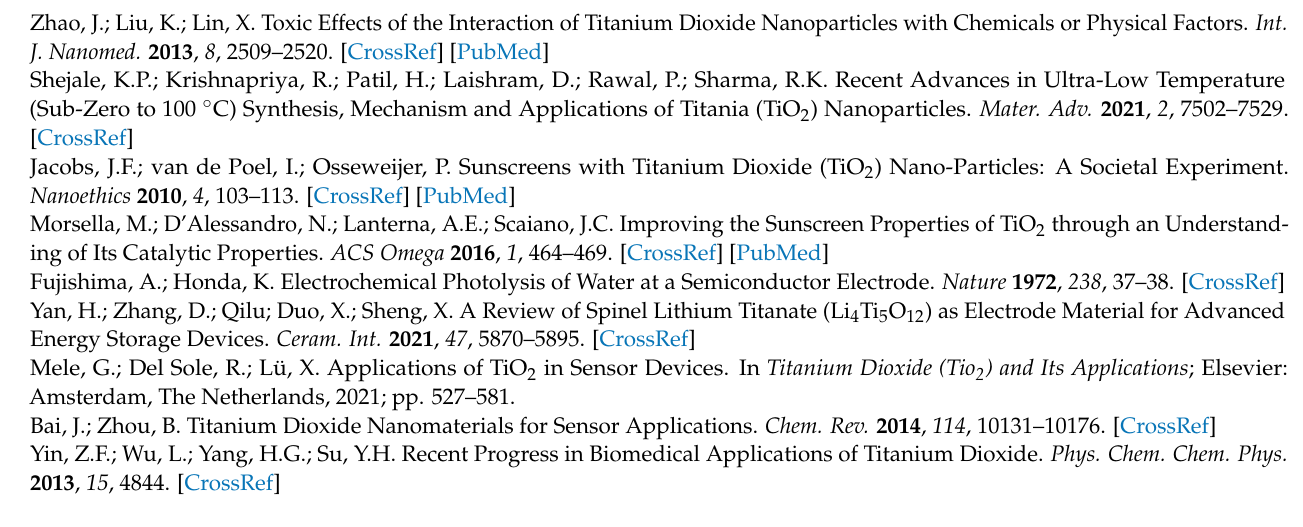
region of the X-band EPR spectrum at − 160 ◦ C, (c) the X-band EPR spectrum of undoped titanium dioxide, (d) simulated X-band EPR spectra of Mn 4+ ions in the crystal fields with strong rhombic distortion; spectra “ a ” and “ b ” differ in the width ( ∆ B ) of the hyperfine structure lines (see Table S4); Figure S7: Zoom-in impedance spectra of the undoped TiO 2 , TO-Mn/F/N-02, TO-Mn/F/N-04, and TO-Mn/F/N-06 materials and the EEC (inset) used for fitting; Figure S8: (a) Evolution of capacity during cycling under various current loads for TO-Mn/F/N-02 and TO-Mn/F/N-06 electrodes, (b) capacity retention at various current densities as compared to that at 70 mA g − 1 for undoped TiO 2 , TO-Mn/F/N-02, TO-Mn/F/N-04, and TO-Mn/F/N-06 materials; Table S1: Specific surface area, total pore volume, band gap energy, and conductivity of TiO 2 samples co-doped with Mn, F, N as compared to unmodified one; Table S2: Quantification results obtained by XPS analysis for TO-Mn/F/N-06 sample; Table S3: The Riveted refinement results for structures existed in unmodified and (Mn, F, N) co-doped TiO 2 samples; Table S4: Spin-Hamiltonian parameters used to simulate the EPR spectra of Mn 4+ ions in crystal fields with strong rhombic distortion; Table S5: Calculated EIS parameters for unmodified and (Mn, F, N) co-doped TiO 2 samples; Table S6: Electrochemical performance of the doped TiO 2 (B) anodes in lithium-ion batteries; Table S7: The fitting results for EIS spectra of electrodes based on undoped TiO 2 and TO-Mn/F/N-04 sample and the calculated lithium diffusion coefficient